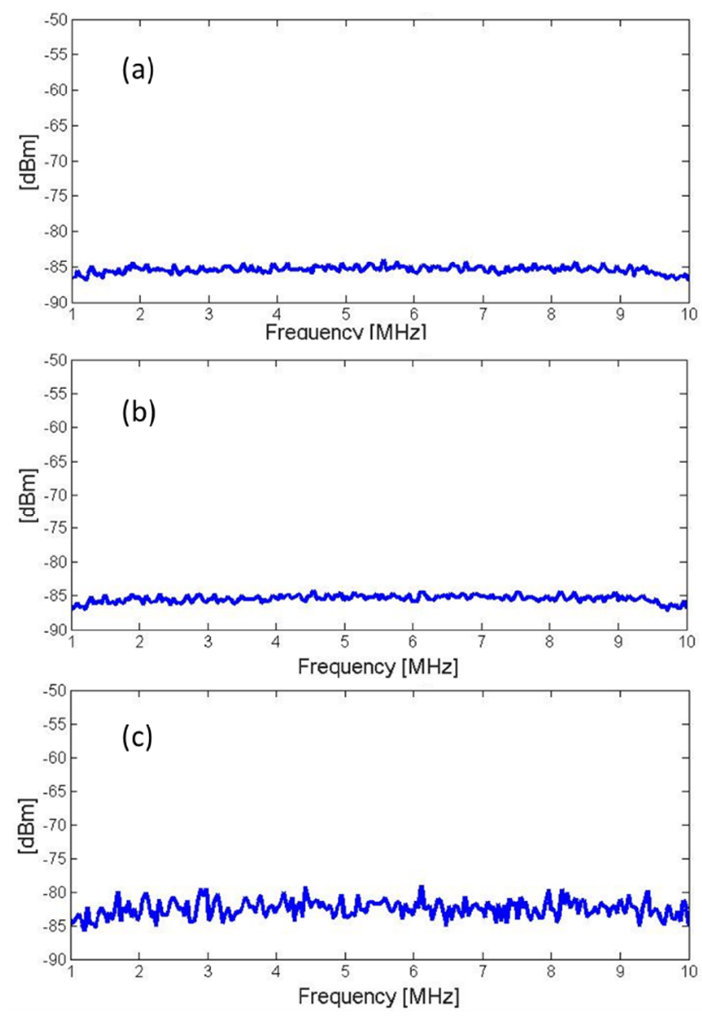
Figure 3. Relative intensity noise (RIN) measurements for three laser sources: ( a ) OPO; ( b ) Ti:Sa; ( c ) SHG.